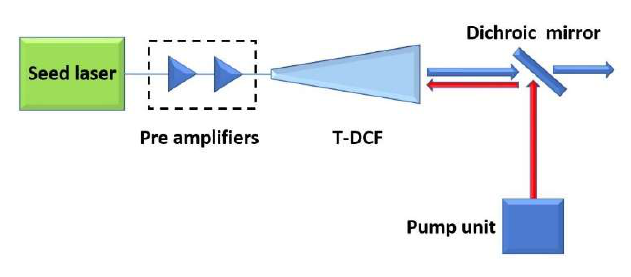
Fig.1. Scheme of the MOPA experimental setup with